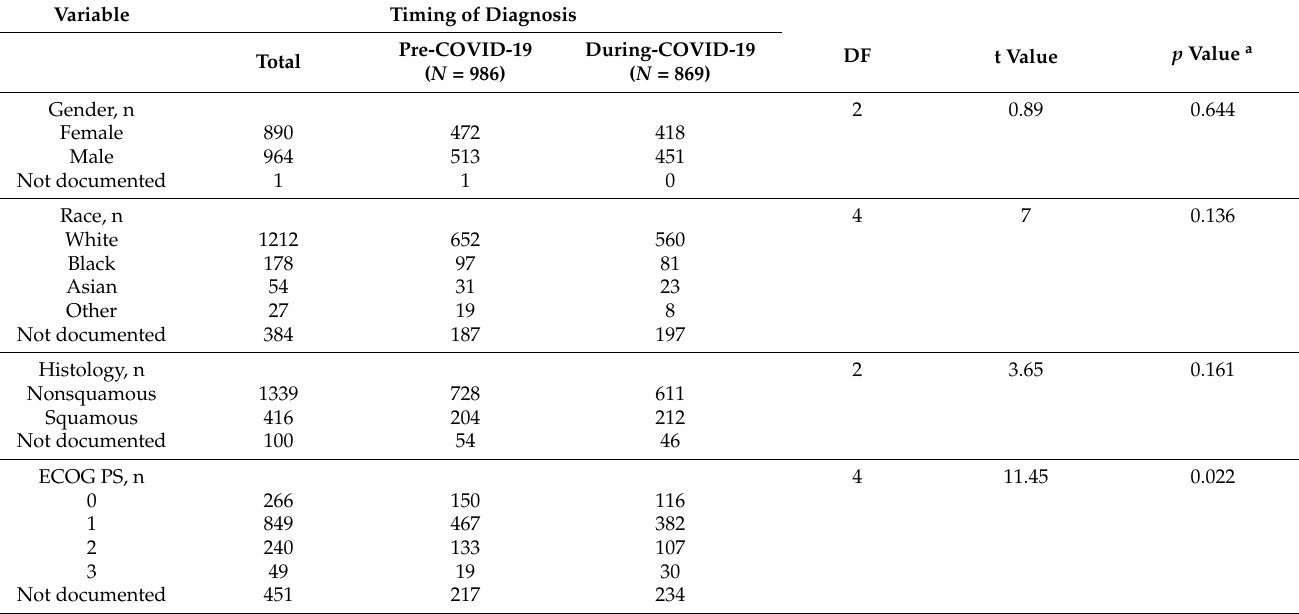
Factors associated with timing of stage IV NSCLC diagnosis: pre-COVID-19 vs.